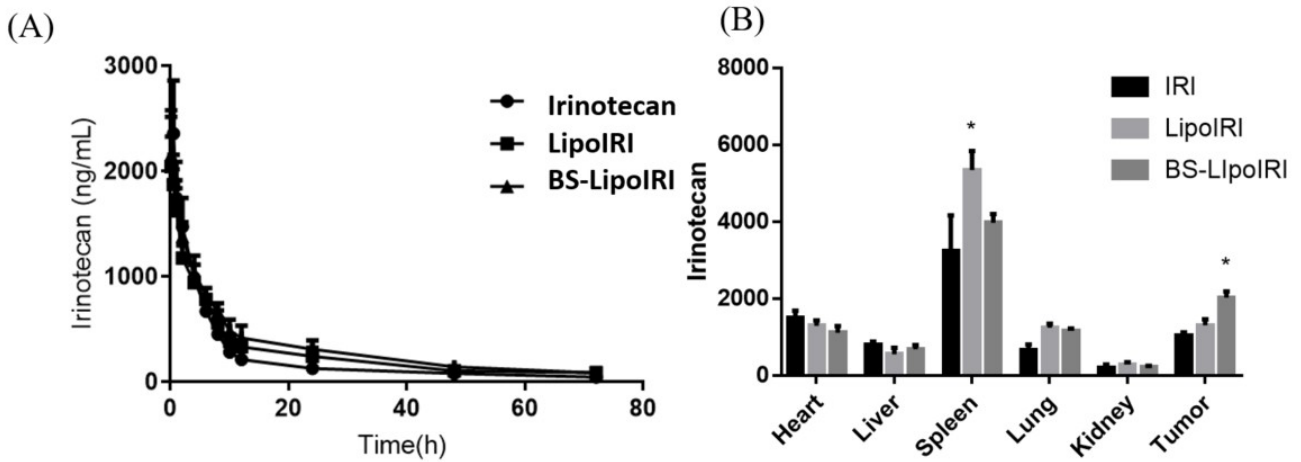
Figure 6. ( A ) Plasma concentration-time curves of irinotecan after intravenous administration of IRI, LipoIRI, and BS − LipoIRI at a dose of 20 mg/kg in rats. ( B ) Tissue distributions of irinotecan at 16 h after intravenous administration of IRI, LipoIRI, and BS − LipoIRI at a dose of 20 mg/kg into BxPC3 tumor-bearing SCID mice. * p < 0.01, a statistically significant difference compared with the IRI group.